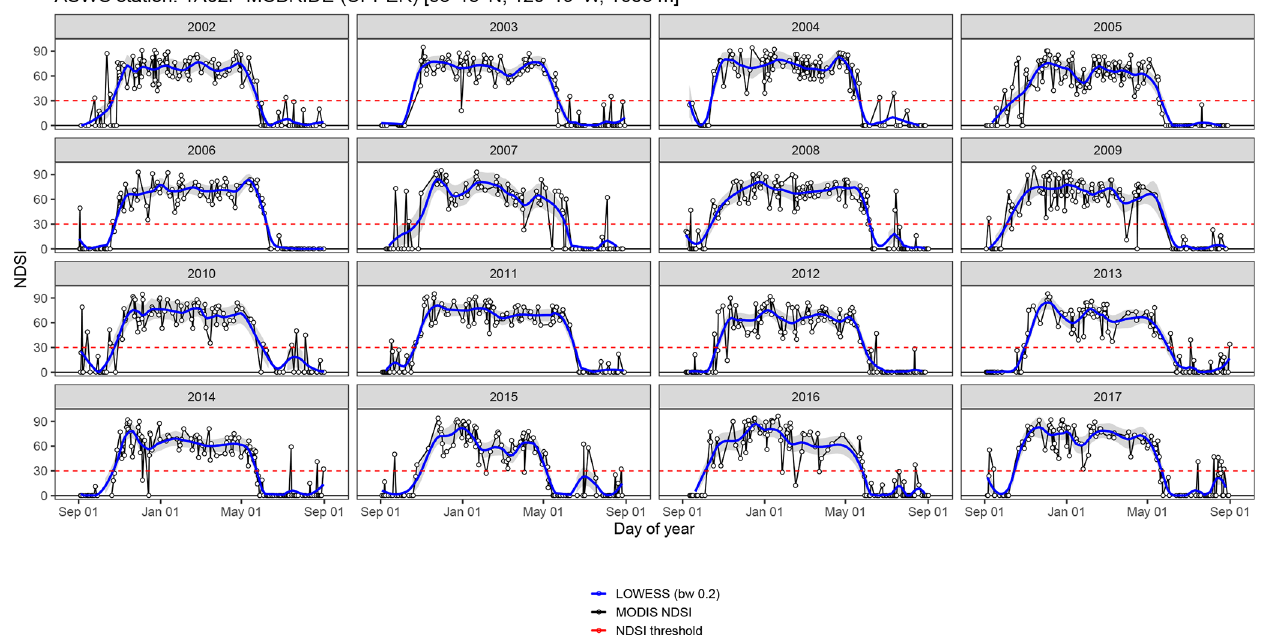
Figure 4. An example of the LOWESS time series interpolation of MODIS NDSI data at the ASWS 1A02P McBride (upper) for the hydrological years 2002–2017. The dashed red line highlights the NDSI threshold of